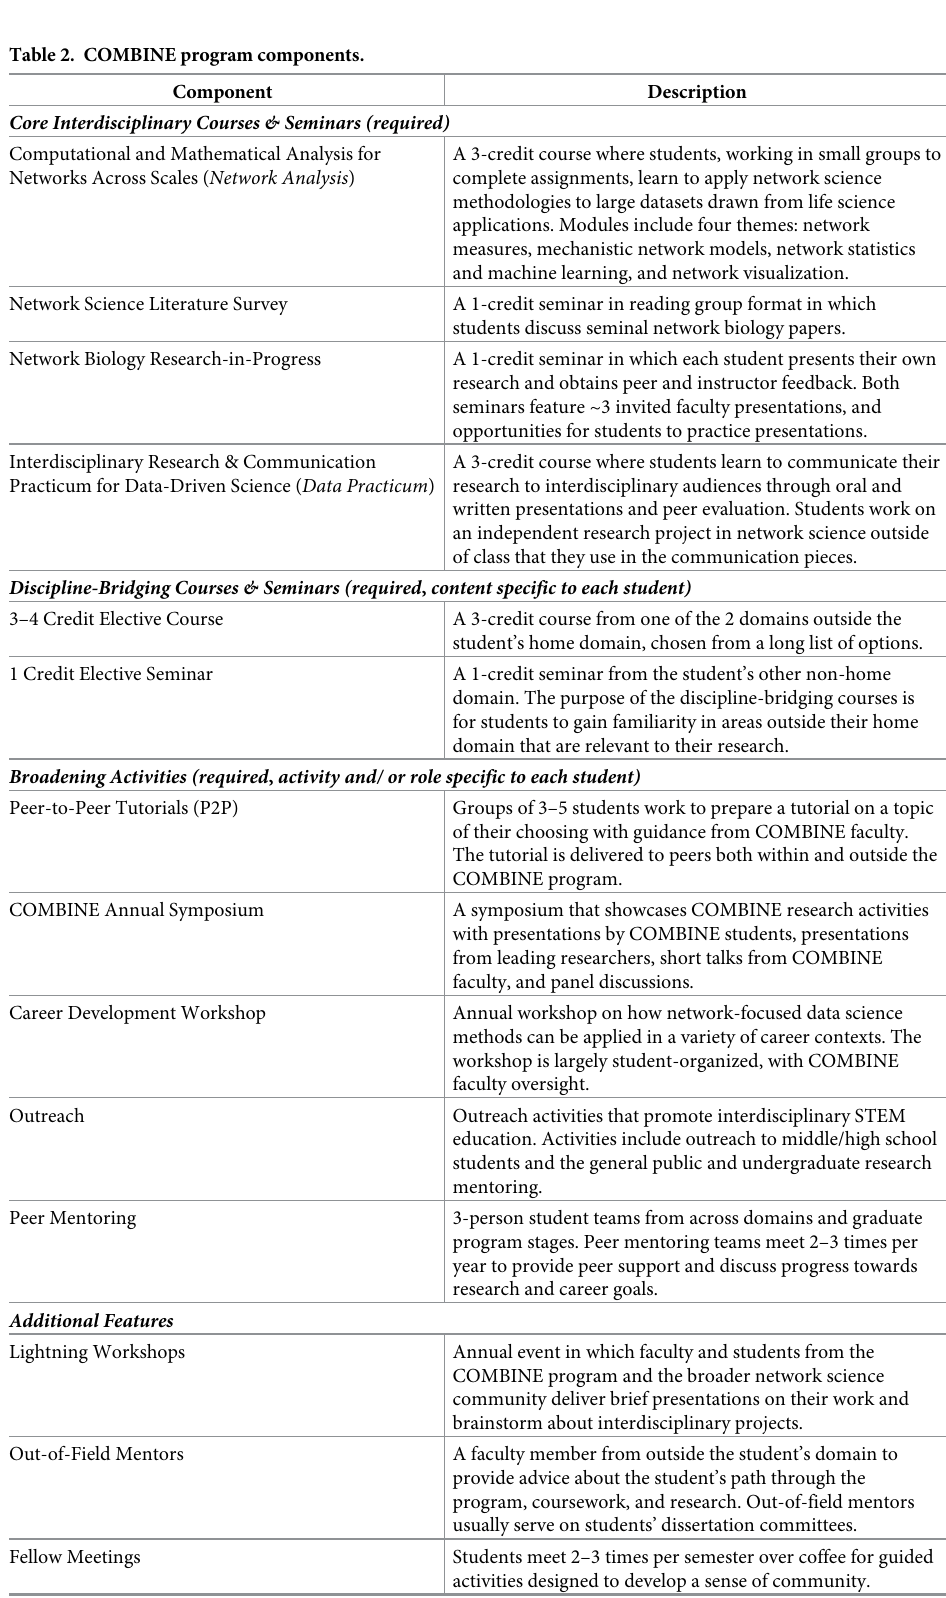
Table 2. COMBINE program